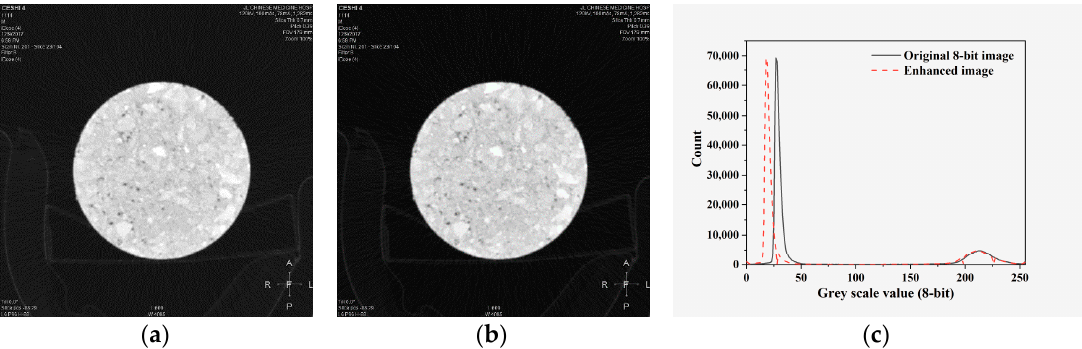
Figure 7. Process of image enhancement: ( a ) original 8-bit image; ( b ) enhanced image; ( c ) gray level histogram.